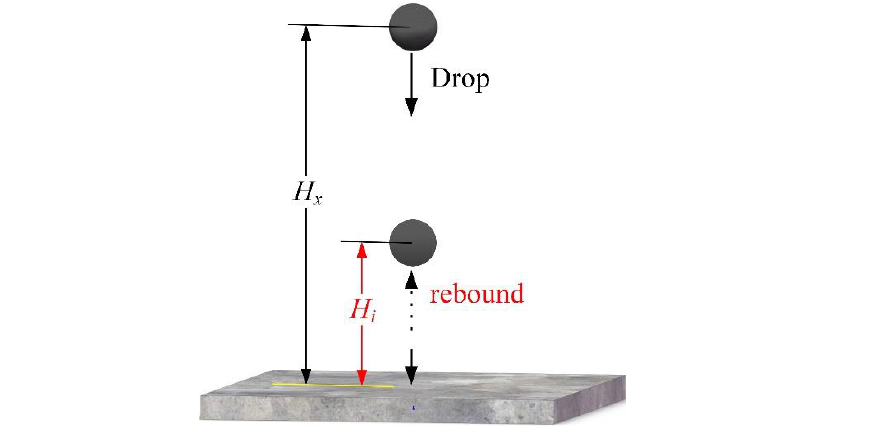
Figure 3. Schematic diagram of restitution coefficient calibration.